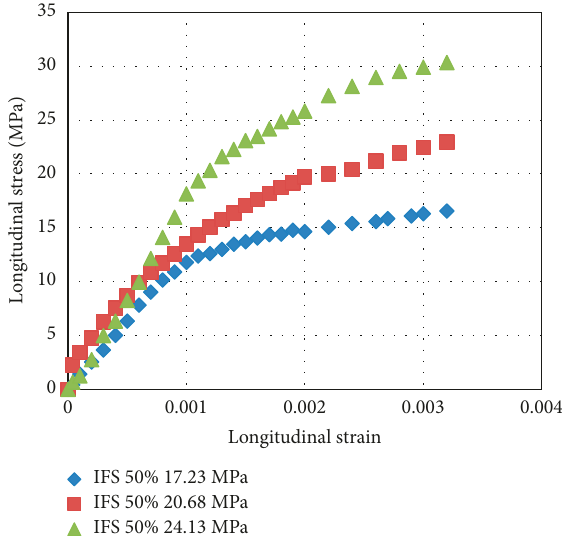
Figure 20: Longitudinal stress-strain diagram RAC with 50% IFS.